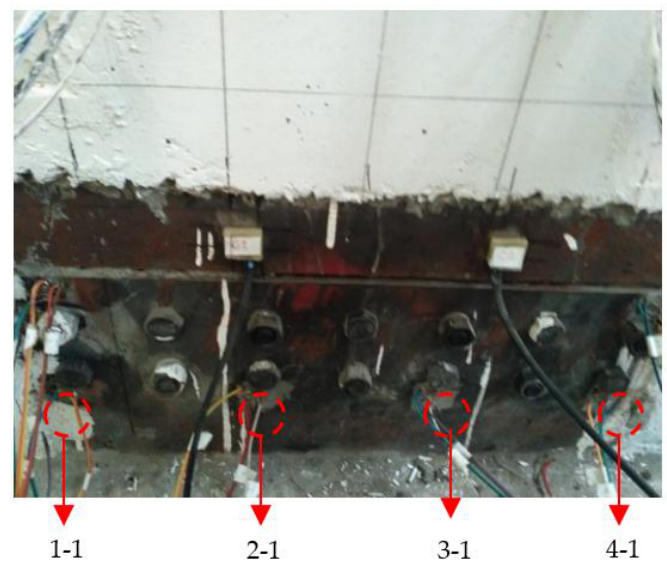
Figure 6. Arrangement of strain rosettes.